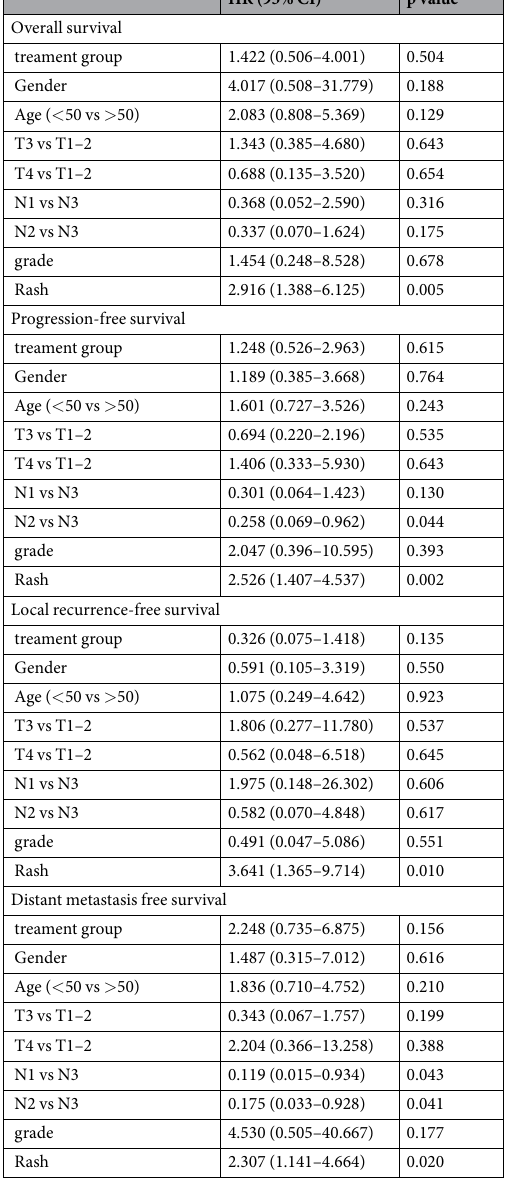
Table 3. Summary of multivariable analyses of prognostic factors. HR = hazard